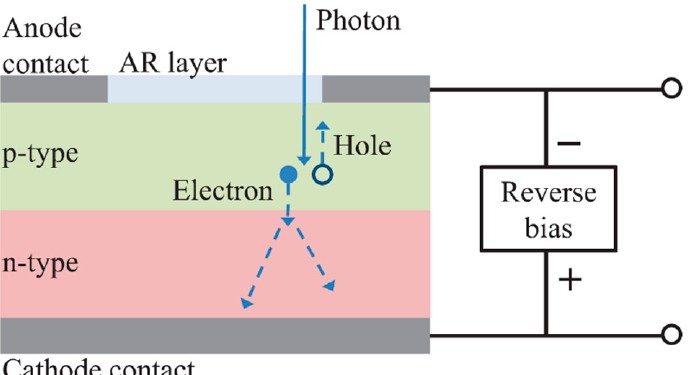
Figure 5. Sketch of a single-photon avalanche diode (SPAD). The voltage is applied to accelerate the electrons toward the multiplication region. A front-illuminated geometry is illustrated, with antireflective (AR) coating to improve efficiency, but back-illuminated designs are also used. Reproduced from [32], with the permission of AIP Publishing, copyright 2011.